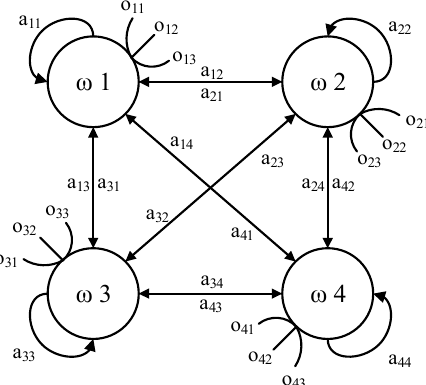
Figure 7. Topological structure of the Hidden Markov Model.